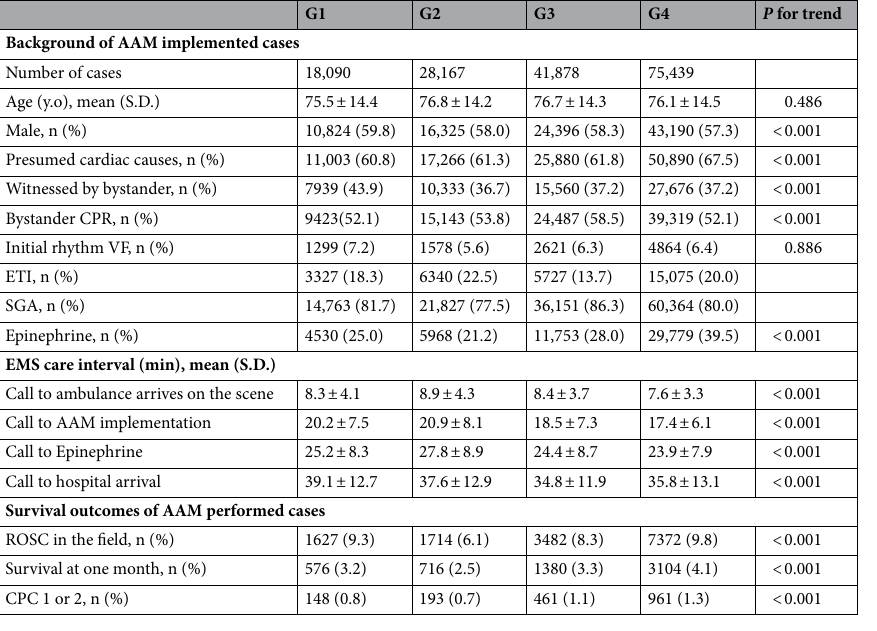
Table 3. Background and survival outcomes of the cardiac arrest cases (AAM implemented cases). CPR cardiopulmonary resuscitation, AAM advanced airway management, ETI endotracheal intubation, SGA supraglottic airway placement, EMS emergency medical service, ROSC return of spontaneous circulation, CPC the cerebral performance category.